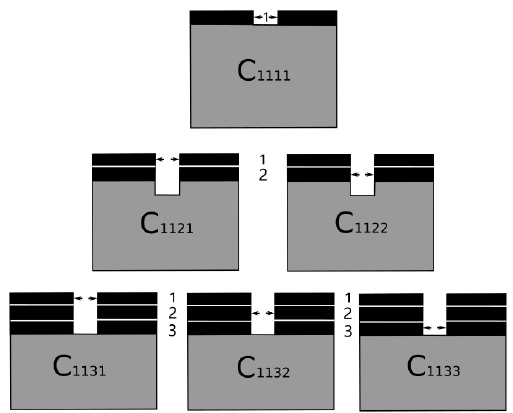
Figure 3. Schematic detailing the stress states and hole depths considered to obtain the calibration coefficients for the three initial drilling increments.